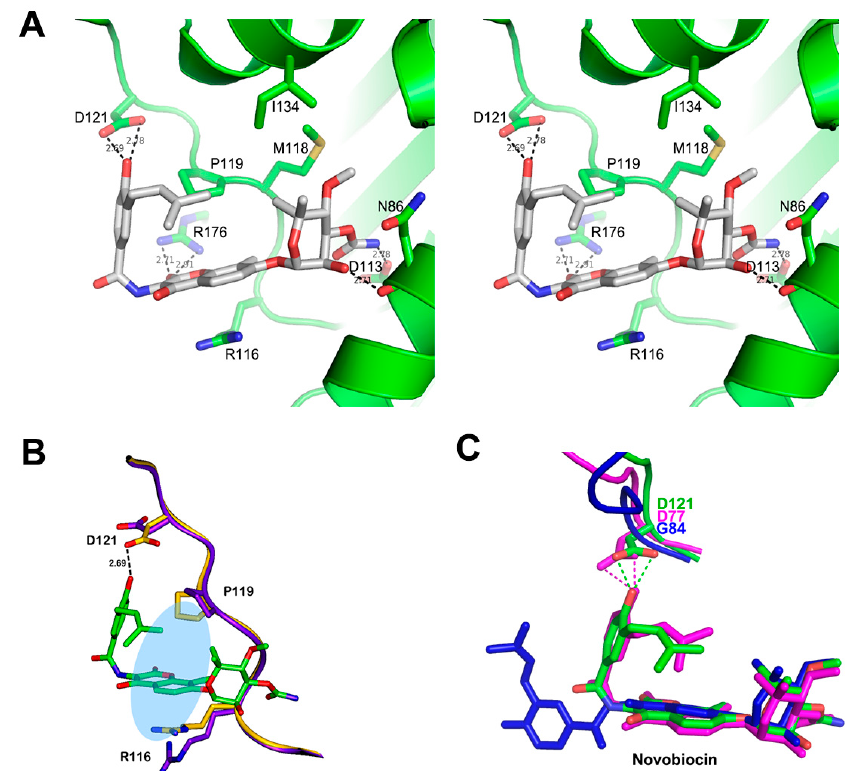
Figure 4. Interaction of novobiocin in the complex. ( A ) Stereoview of the detailed interactions of novobiocin with Xoo ParE. The carbon atoms from novobiocin and Xoo ParE are colored white and green, respectively. The residues of Xoo ParE involved in the interaction are labelled and hydrogen bonds are indicated with dashed lines. ( B ) Conformational change of the side chains of the residues in the novobiocin-binding site of Xoo ParE. The carbon atoms of Xoo ParE from the apo form and the novobiocin complex are colored purple and yellow, respectively. The ellipse indicates the interaction of the coumarin moiety of novobiocin with Pro119 and Arg116. ( C ) Structural comparison of novobiocin in the complex structures. The novobiocin complex structures with Xoo ParE (green), E. coli ParE (purple, PDB code 1S14), and S. aureus ParE (blue, PDB code 4URN) are superimposed.